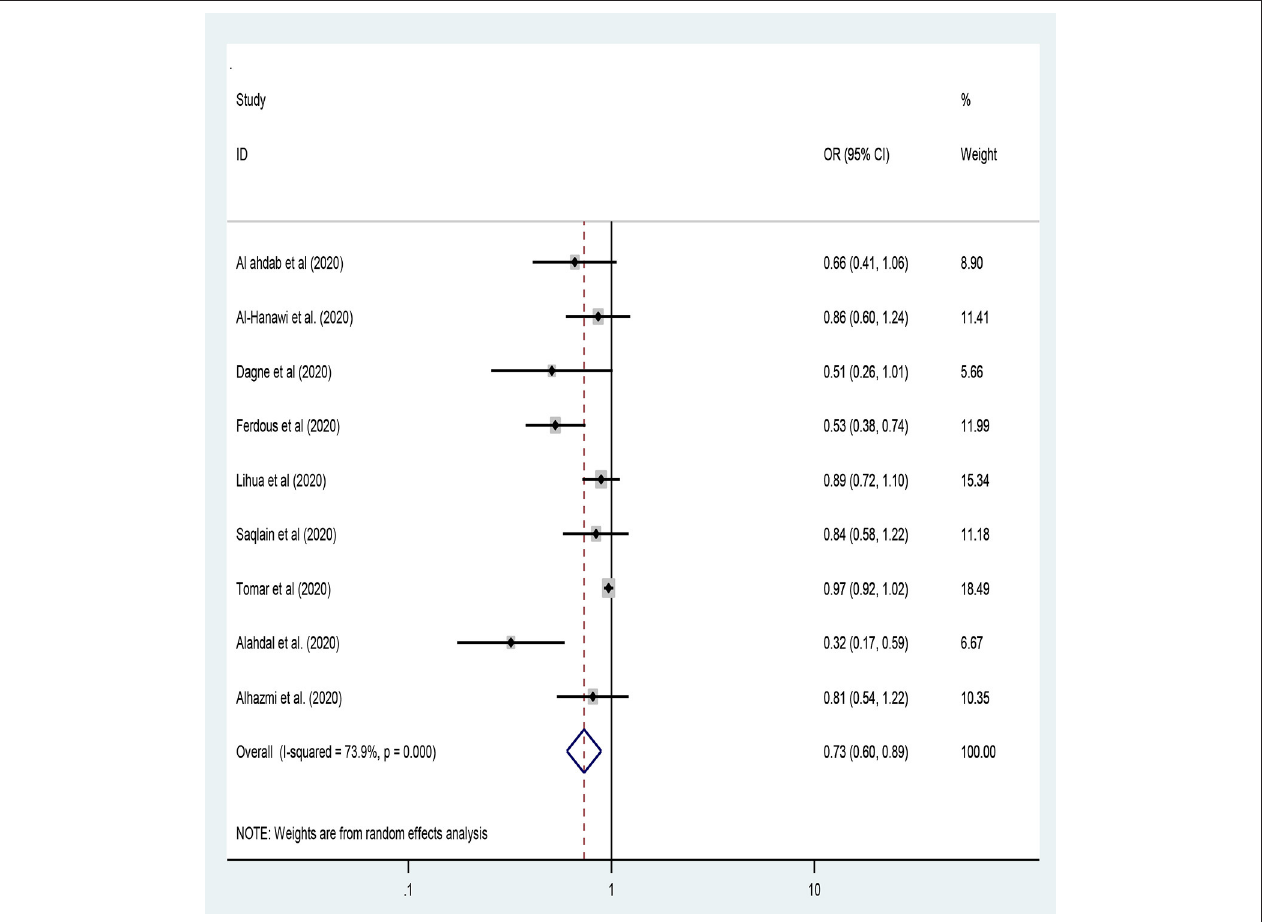
FIGURE 9 | The age category of participants and preventive practice toward